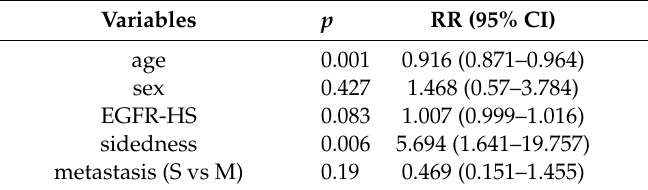
Table 3. Multivariant analysis of various prognostic / predictive factors of cetuximab e ffi cacy using the Cox proportional hazard model for overall survival: EGFR protein expression of the metastases ( N = 29).